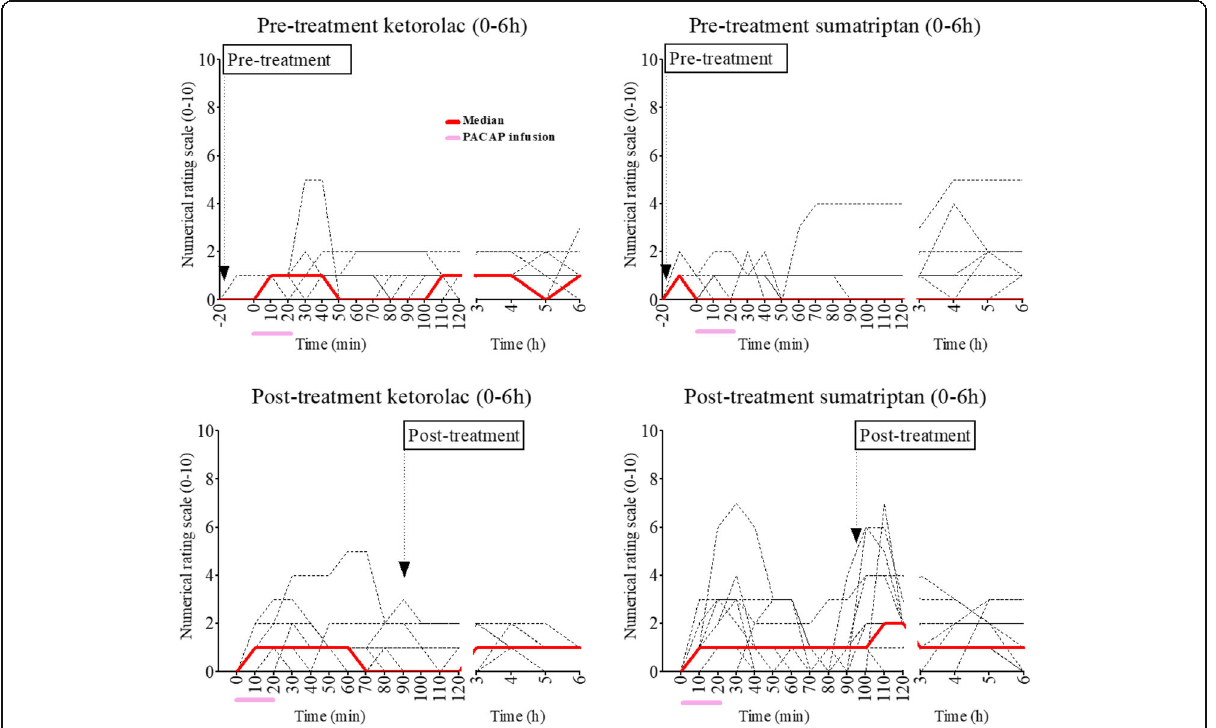
Fig. 2 Headache intensity of individual volunteers (black lines) and the median headache intensity (red line) after PACAP38 and pre-treatment with ketorolac /sumatriptan ( n = 17) and post-treatment with ketorolac /sumatriptan (n =